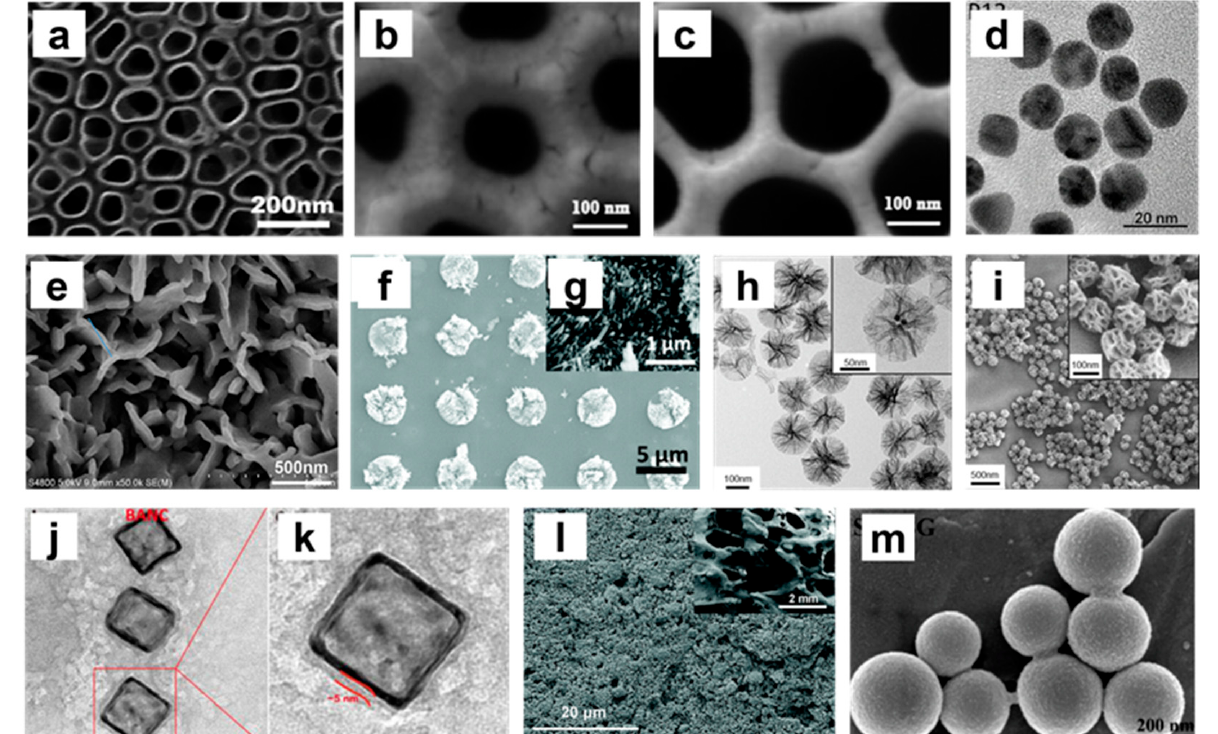
Figure 5. Composite images (TEM and SEM images) of different nanoparticle structures. ( a ) SEM image of 110 nm titania nanotubes (TNTs) [116]; ( b , c ) SEM images of anodic alumina structures with different sized pores (100 nm and 200 nm) [119]; ( d ) TEM image of peptide-coated gold NPs (P12) [112]; ( e ) SEM image of surface morphology of SIS/SrHA [150]; ( f , g ) SEM images of HA bioceramics with nanoneedle structures. (g: high magnification image) [120]; ( h ) TEM images of 150 nm extra- large pore mesoporous silica NPs (XL-MSNs) (inset: high magnification image) [133]; ( i ) SEM im- ages of 150 nm XL-MSNs (inset: high magnification image) [133]; ( j , k ) TEM images of biomimetic anti-inflammatory nano-capsules (BANC) [139]; ( l ) SEM image of 5 wt% ZnO incorporated micro- crystalline bioactive glass (5Zn-MCBG) [149]; ( m ) SEM image of strontium-substituted submicrom- eter bioactive glass (Sr–SBG) [124]. Reprinted/adapted with permission from Ref. [112]. Copyright